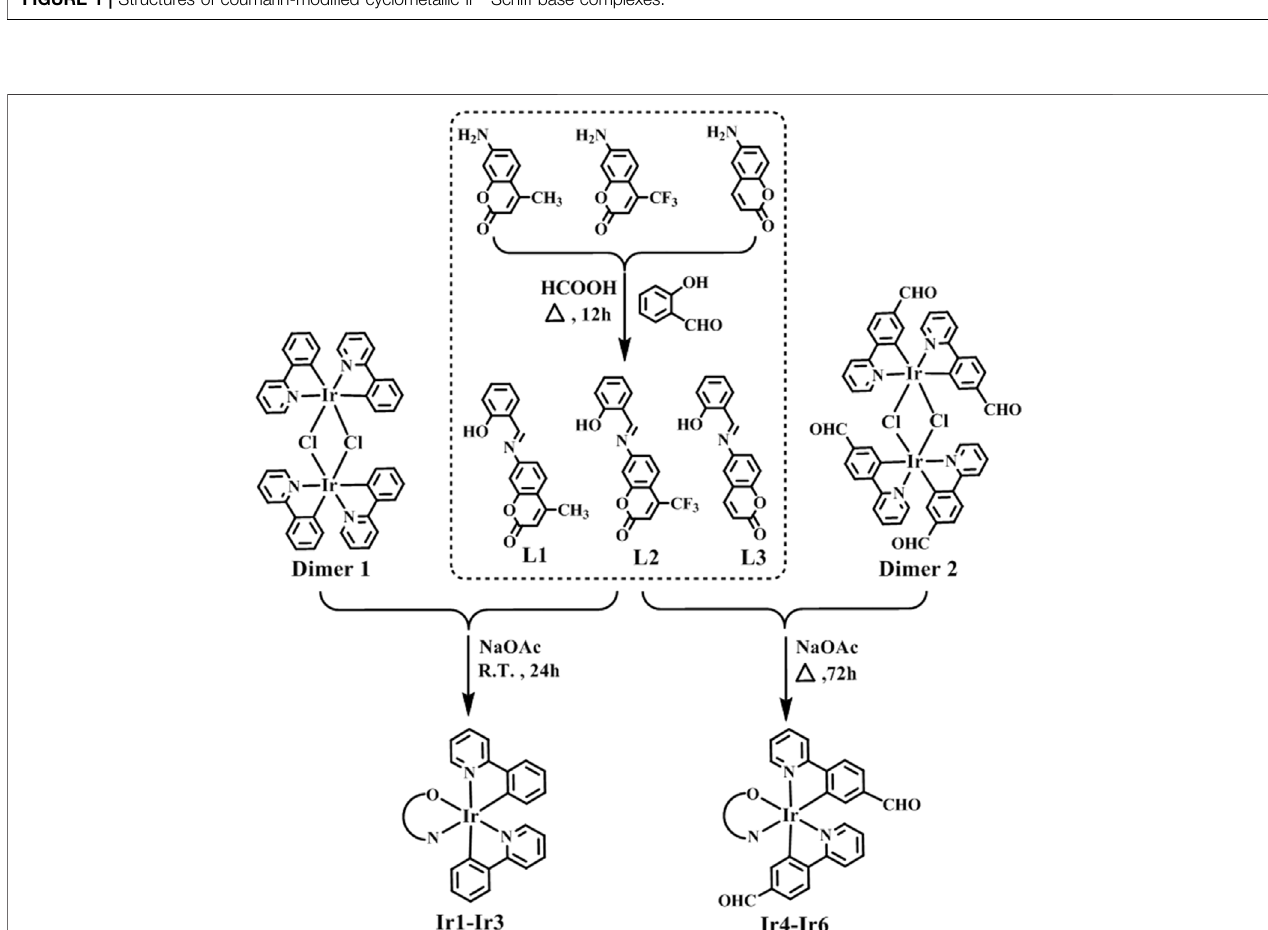
SCHEME 1 | Synthesis process of coumarin-appended cyclometallic Ir III complexes (Ir1-Ir6).